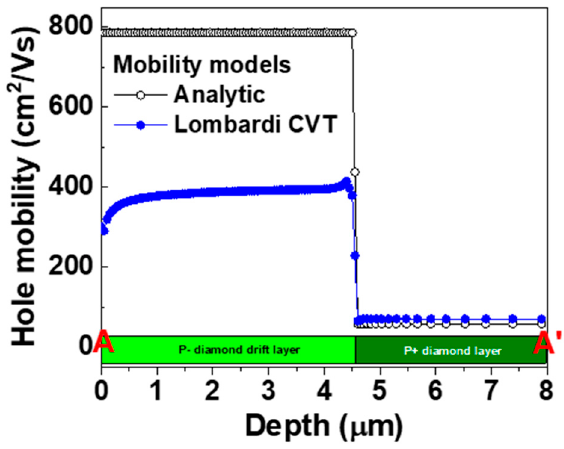
Figure 7. Hole mobility across the A-A’ section line of the p-type diamond pseudo-vertical Schottky